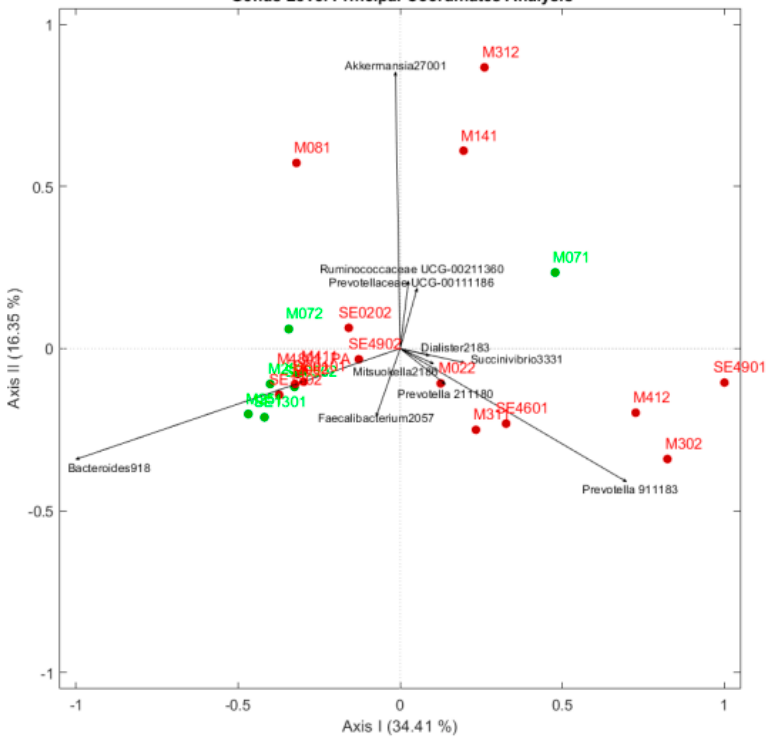
Figure 7. Beta diversity analyses at the genus level: PCoA based on Bray–Curtis distance measure. Green: OSA − atherosclerosis. Red: OSA + atherosclerosis.